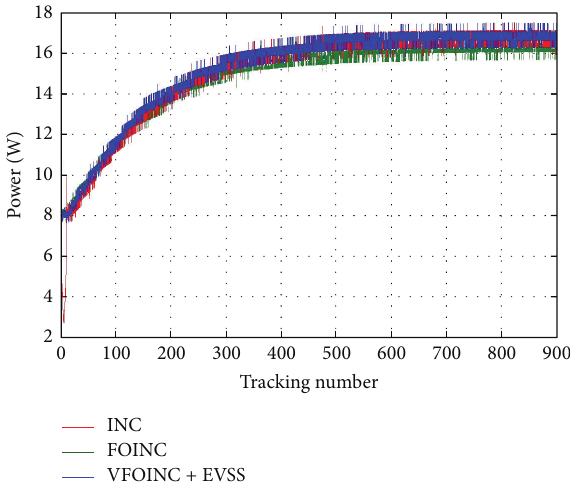
Figure 15: Experimental comparison of INC and FOINC with VSS and VFOINC with EVSS (fixed irradiance).